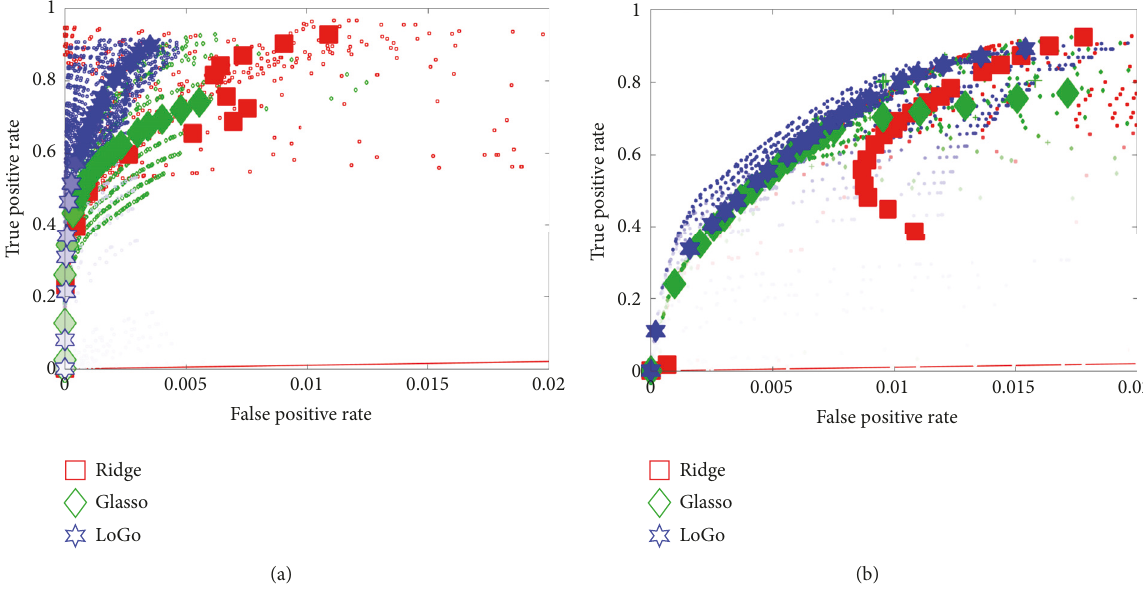
Figure 5: ROC values, for conditional (a) and unconditional (b) transfer entropies . 𝑥 -axis false positive rates (FP /𝑚 ); 𝑦 -axis true positive rates (TP /𝑛 ). Large symbols refer to 𝛾 = 0.1 and validation at 𝑝 value 𝑝 V = 0.01 . Color intensity is proportional to time series length. Inference network results are all outside the range of the plot. Reported values are averages over 100 processes.